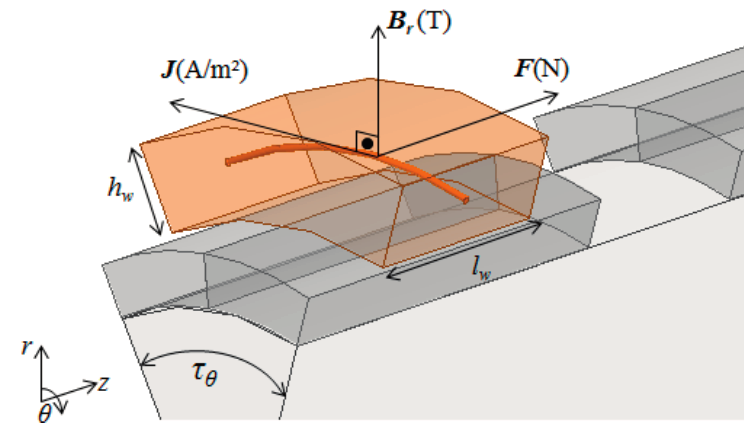
Figure 7. Vectors of radial component of magnetic flux density B J and force F over a generic electric